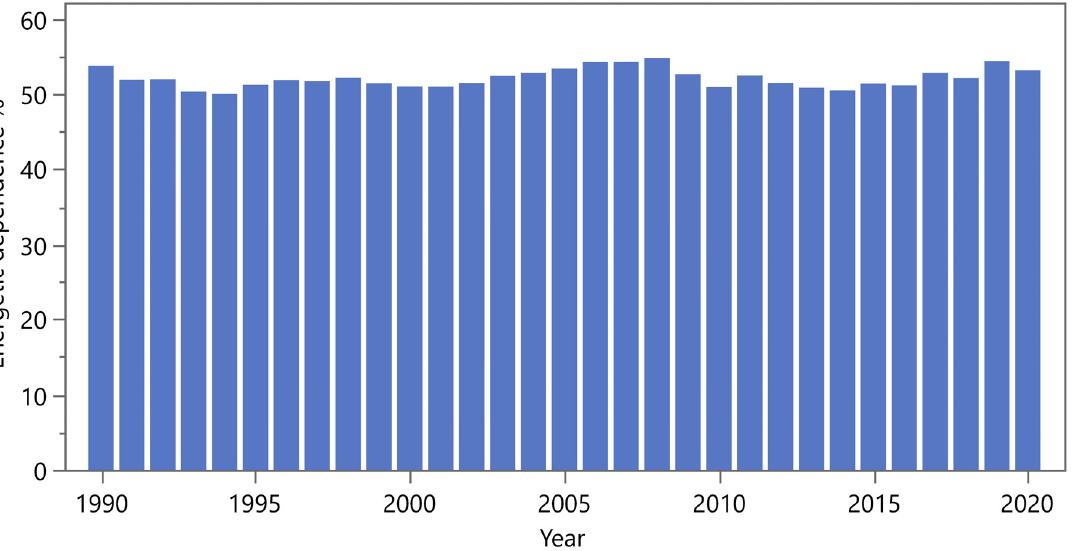
Figure 7. Energy dependence—graphical analysis of the variability according to EU member states, excluding Norway. Source: own processing according to [20], processing in JMP.